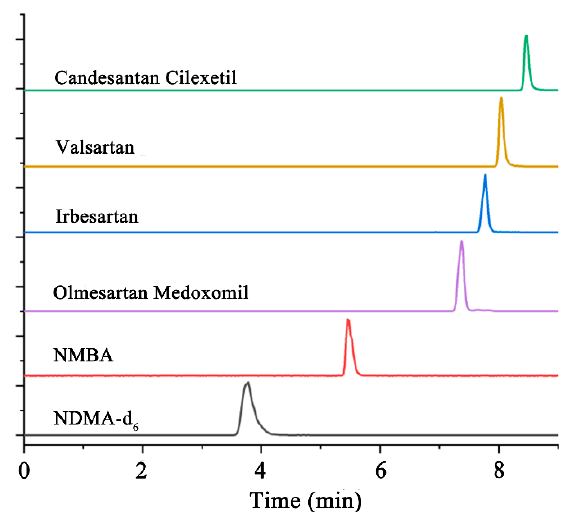
Figure 2. HPLC chromatograms of NDMA-d 6 , NMBA and four kinds of sartan substances on the C18 column.